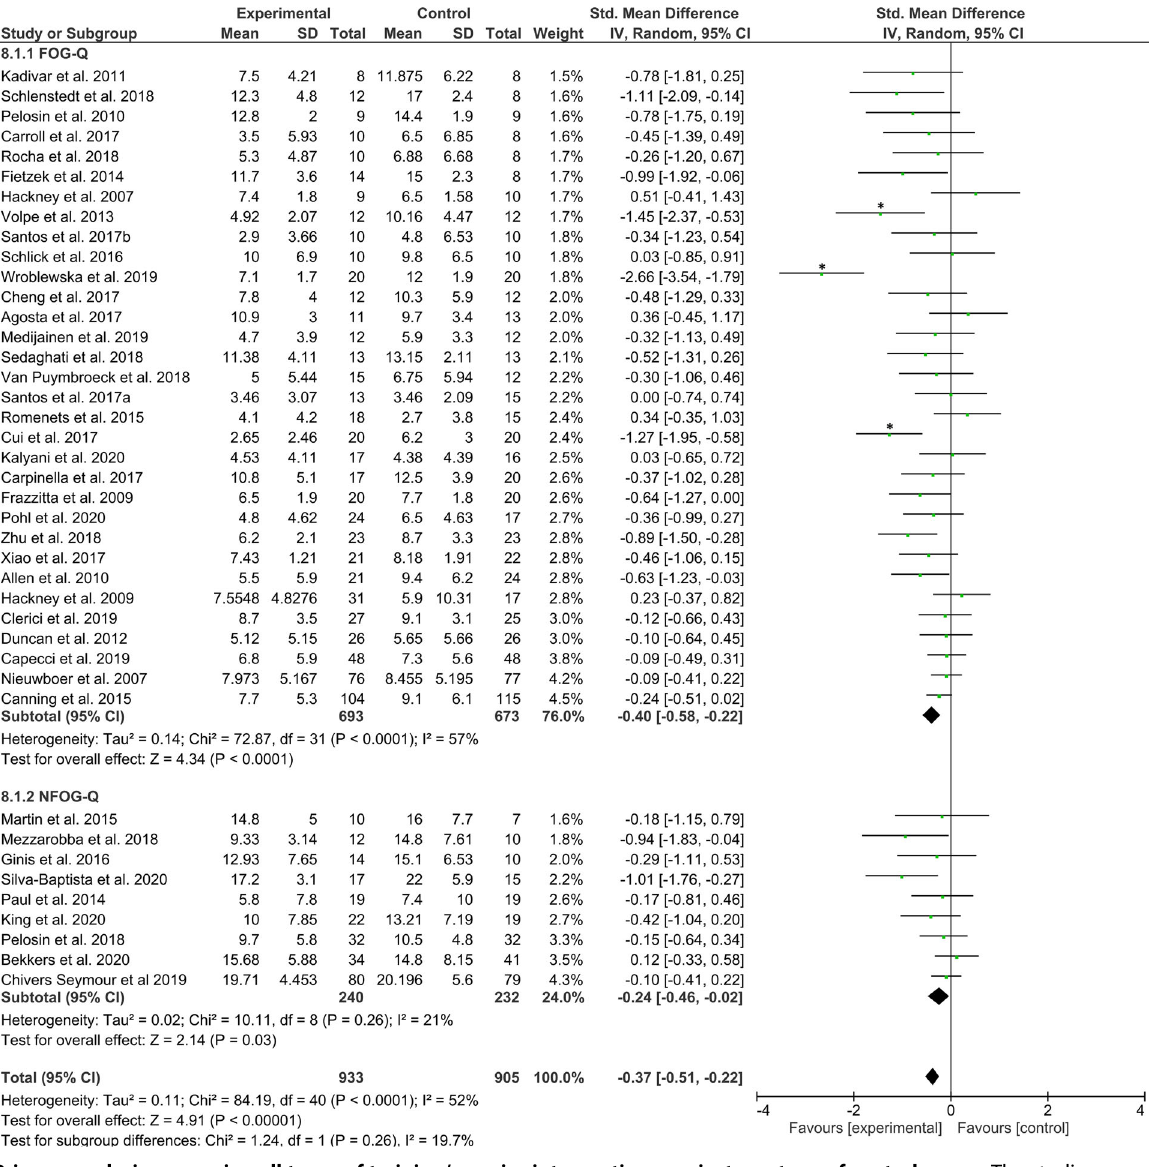
Fig. 3 Primary analysis comparing all types of training/exercise interventions against any type of control group. The studies are arranged per weight of the study determined by sample size; *signi fi cant outliers removed in the sensitivity